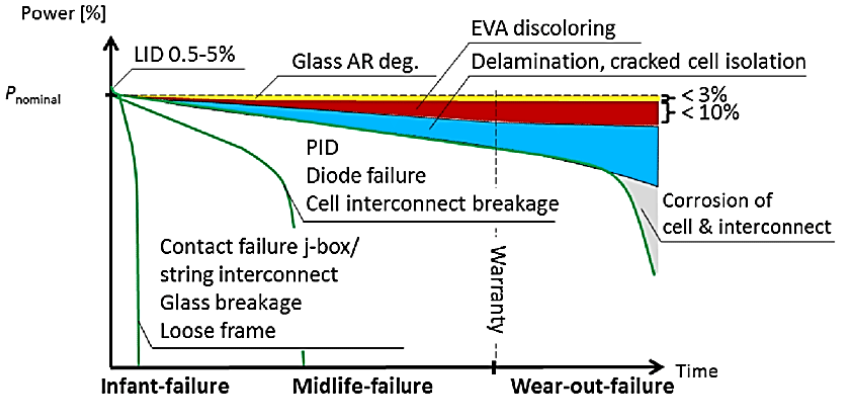
Figure 1. Power loss due to delamination and corrosion.